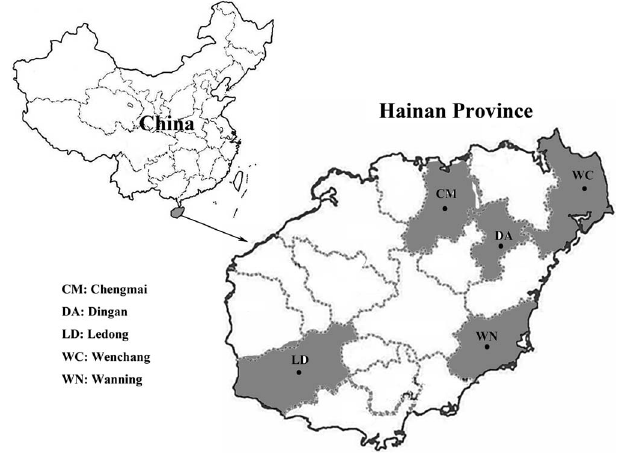
Figure 1. Speci fi c locations where samples were collected in this study. d Sampling